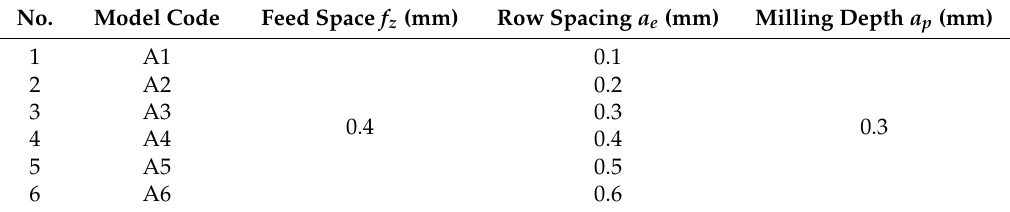
Table 3. Milling parameters of quadrilateral structures with row spacing changes.